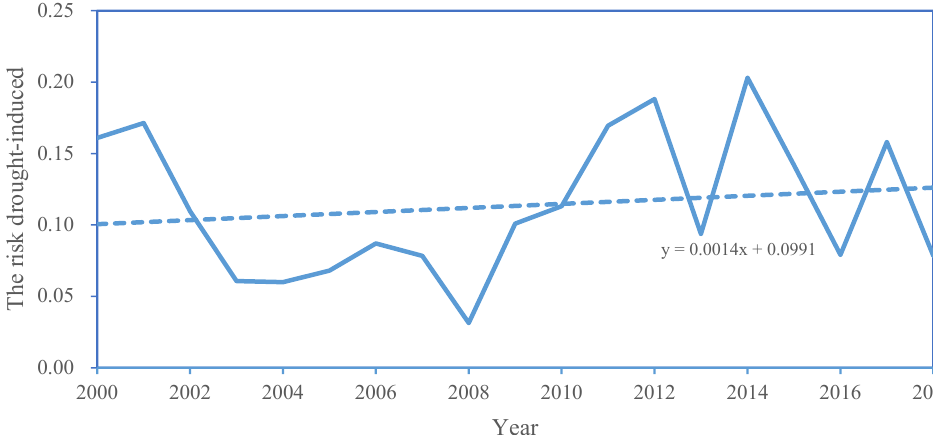
Figure 6. Change trend of drought-induced risk on the North China Plain in summer from 2000 to 2018. The changes in SPEI and CWSI both indicated that the drought in the North China Plain is gradually increasing, which was different from the situation in the other three seasons. The drought intensity in North China Plain was the highest in spring, but it weakened insignificantly; the drought intensity in autumn was also large, and it also gradually increased, with a rapid increase rate; the drought intensity in winter was low, but its increase rate was the fastest. In contrast, the increase rate of drought in summer was smaller. The drought-induced risk in summer were mainly low and slightly low (Figure 7a). The area proportion of low risk is 37.23%; the area proportion of slightly low risk accounts for 24%; medium risk accounts for 21.03%; and slightly high risk and high risk account for a relatively small proportion, which are 15.64% and 2.1%, respectively. However, the risk change was characterized by a decrease in the north and an increase in the south. There were increasing trends in southern Shandong, eastern Henan and northern Anhui and Jiangsu Provinces (Figure 7b). The significantly increasing risks were in Xuchang, Pingdingshan and Zhoukou in Henan Province and Suzhou and Bozhou in Anhui Province, while the decreasing risks were concentrated in